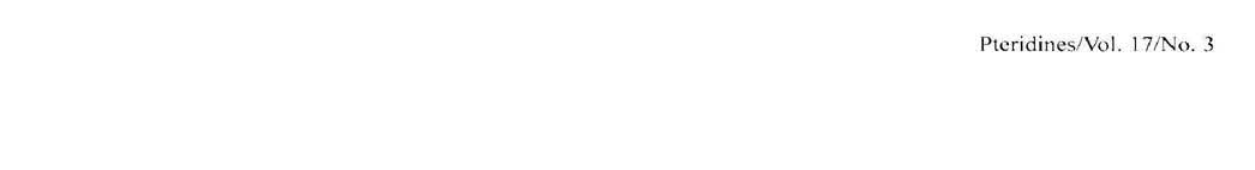
Figure 3 Effects of intracellular biopterin on L-tyro- sine-indueed [Ca 2 ]¡ elevation in HIT-T15 cells. In A, cells were incubated with DAHP (1 mM) and sepi- aptcrin ( 1 -100 μΜ ) for 6 h. Total biopterin levels were determined. In B. the effects of pretreatment with DAHP ( 1 mM) and/or DAHP (1 mM) and sepiapterin (10 μΜ) on the peak levels of L-tyrosine (5 mM)- induced [Ca : ], elevation was measured. Cells were pretreated with DAHP ( 1 mM) and/or sepiapterin ( 10 μΜ ) for 6 h. The ratio in panel Β indicates the absolute changes of ratio intensity (Δ ratio (340/380 nm) — peak ratio - resting ratio). Results are the average of 53-74